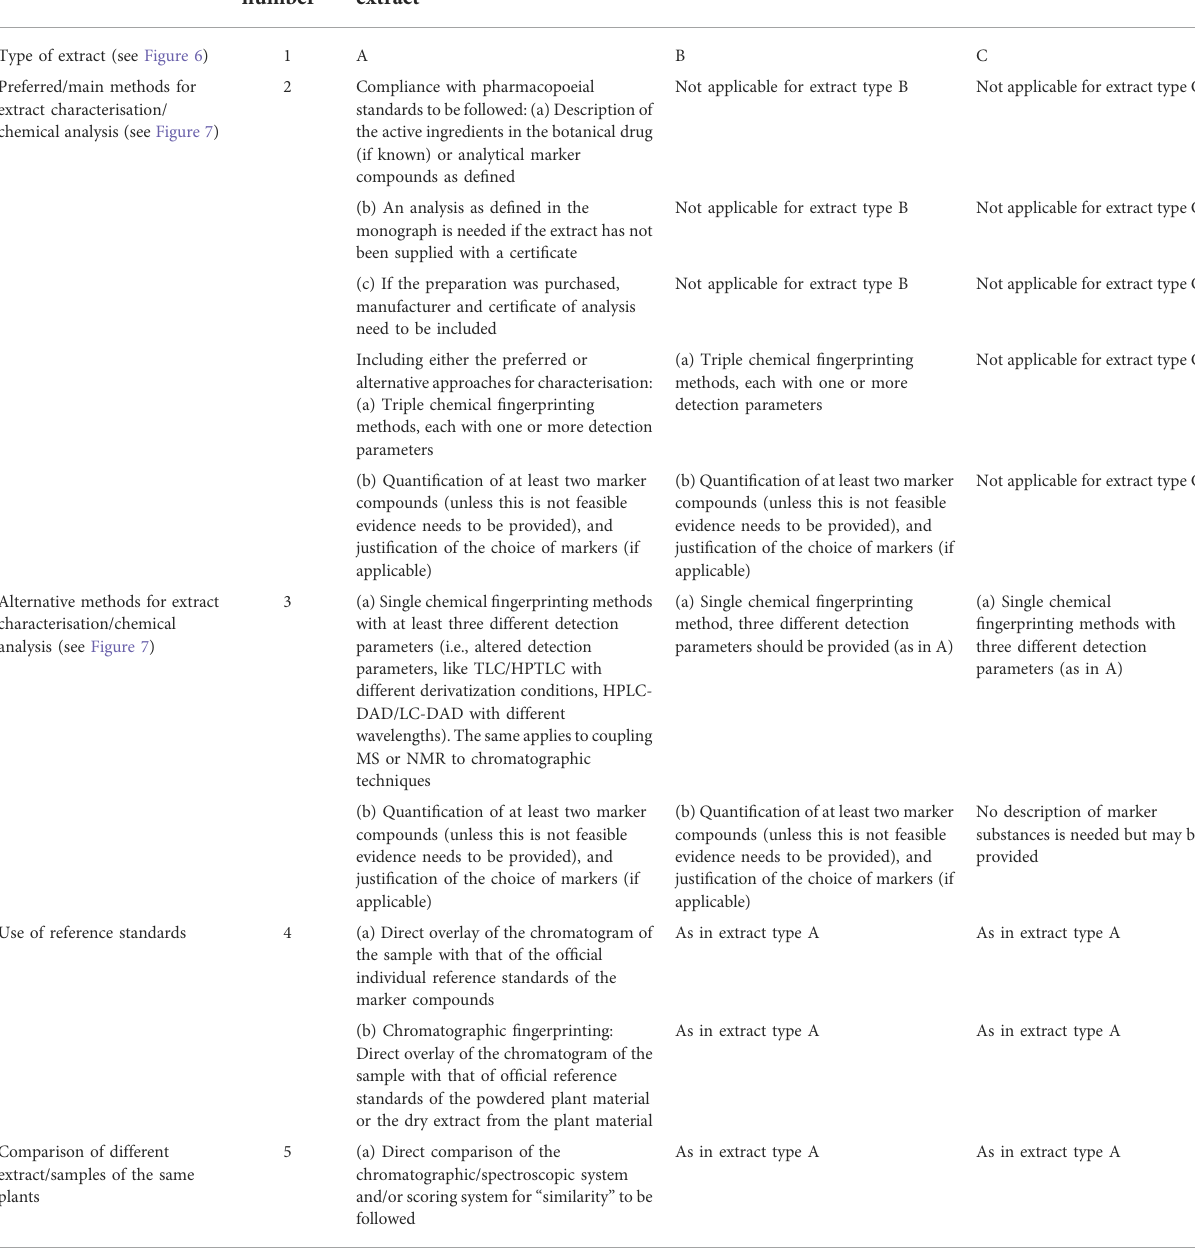
TABLE 4 Recommendations (checklist of items) for most suitable analytical methods for de fi ning the chemical pro fi le for different types of